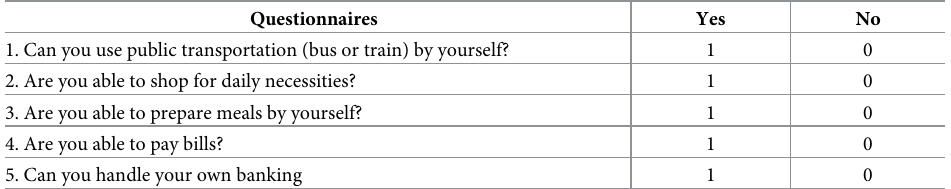
Table 1. Instrumental activities of daily living (IADL) subscale of The Tokyo Metropolitan Institute of Gerontol- ogy Index of Competence (TMIG-IC).